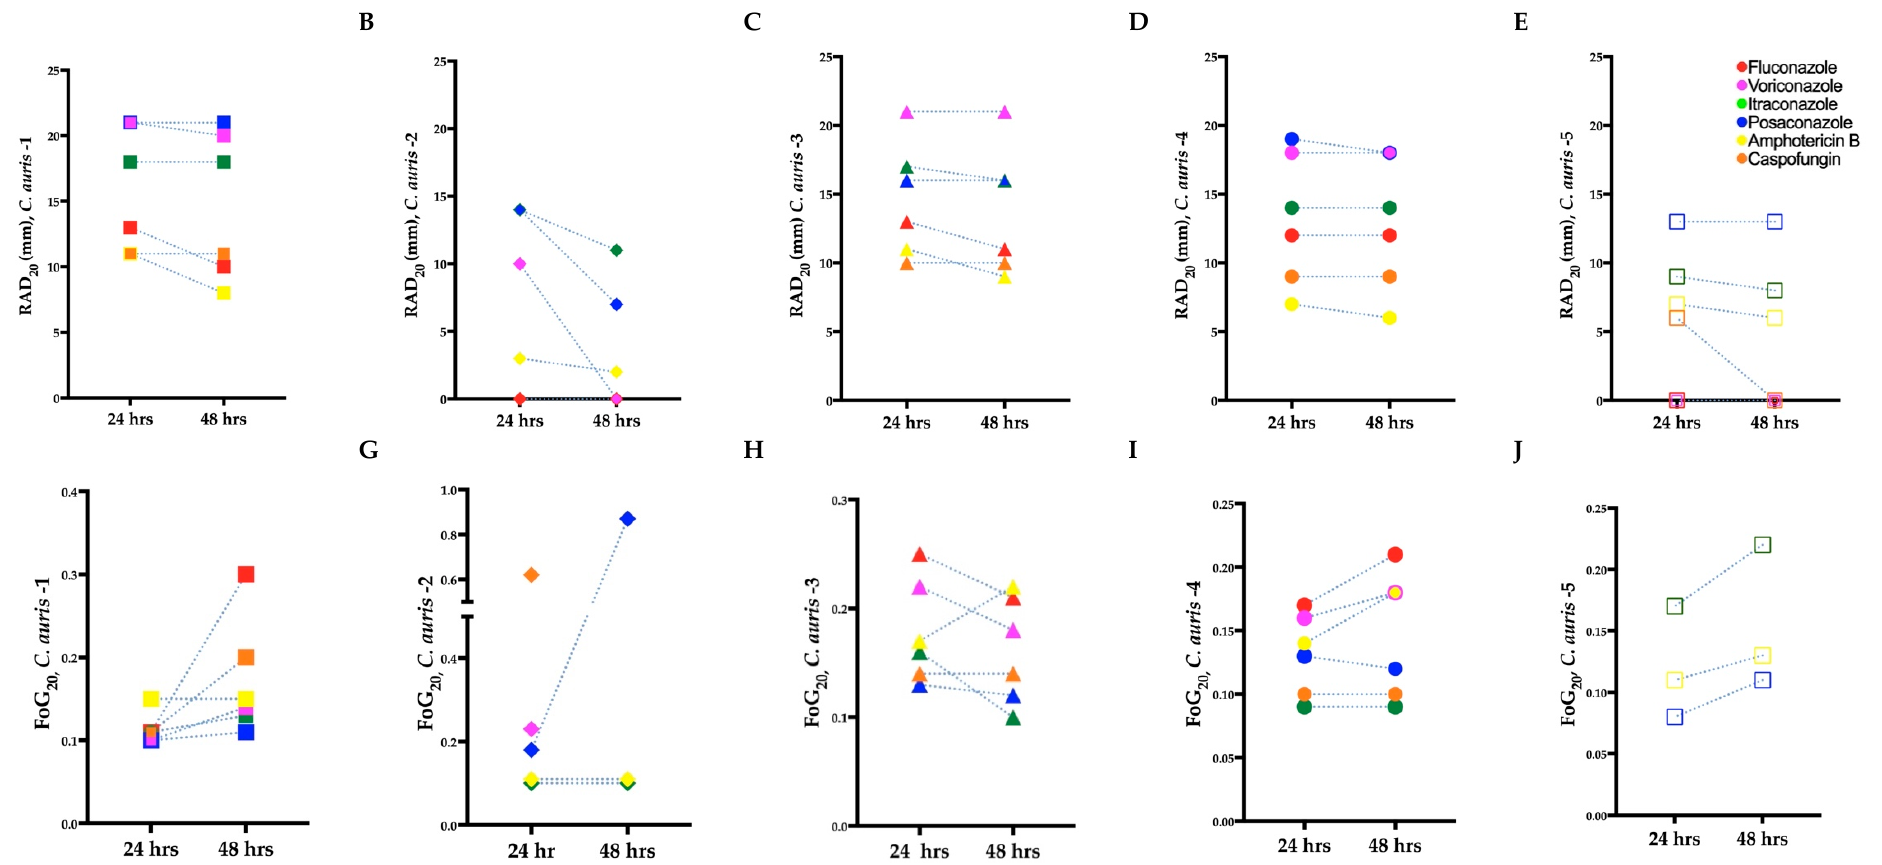
Figure 2. Radius of the zone of inhibition (RAD) ( A – E ) and fraction of growth in the zone of inhibition (FoG 20 ) ( F – J ) for C. auris isolates treated with antifungal drugs. Mean RAD where 20% of growth is inhibited (RAD 20 ) at 24 and 48 h. ( B ) Mean FoG where 20% of growth is inhibited (FoG 20 ) 24 and 48 h. C. auris isolate 2 treated with caspofungin at 48 h is not plotted in ( B ), as it exhibited FoG in the entire ZOI (i.e., a “NA” data point was generated by diskImageR [29]); the reduction in RAD and FoG 20 for C. auris isolate 3 in ( C ) and ( H ), respectively, is due to the exclusion of FoG 20 within the ZOI by diskImageR (see Section 2.5 for details). C. auris isolate 5 exhibited resistances to fluconazole and caspofungin.